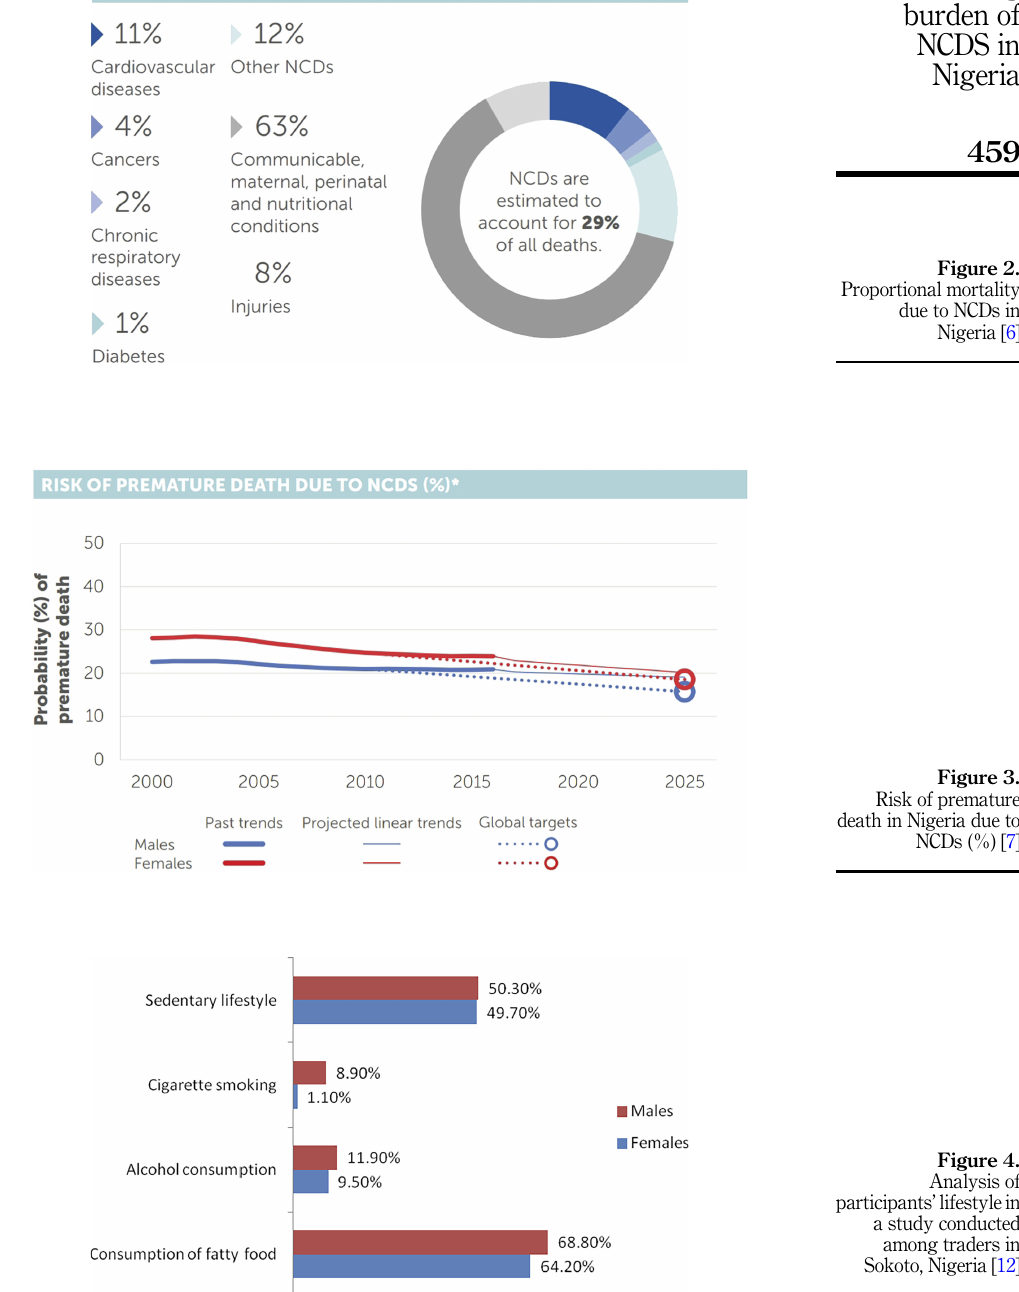
Figure 4. Analysis